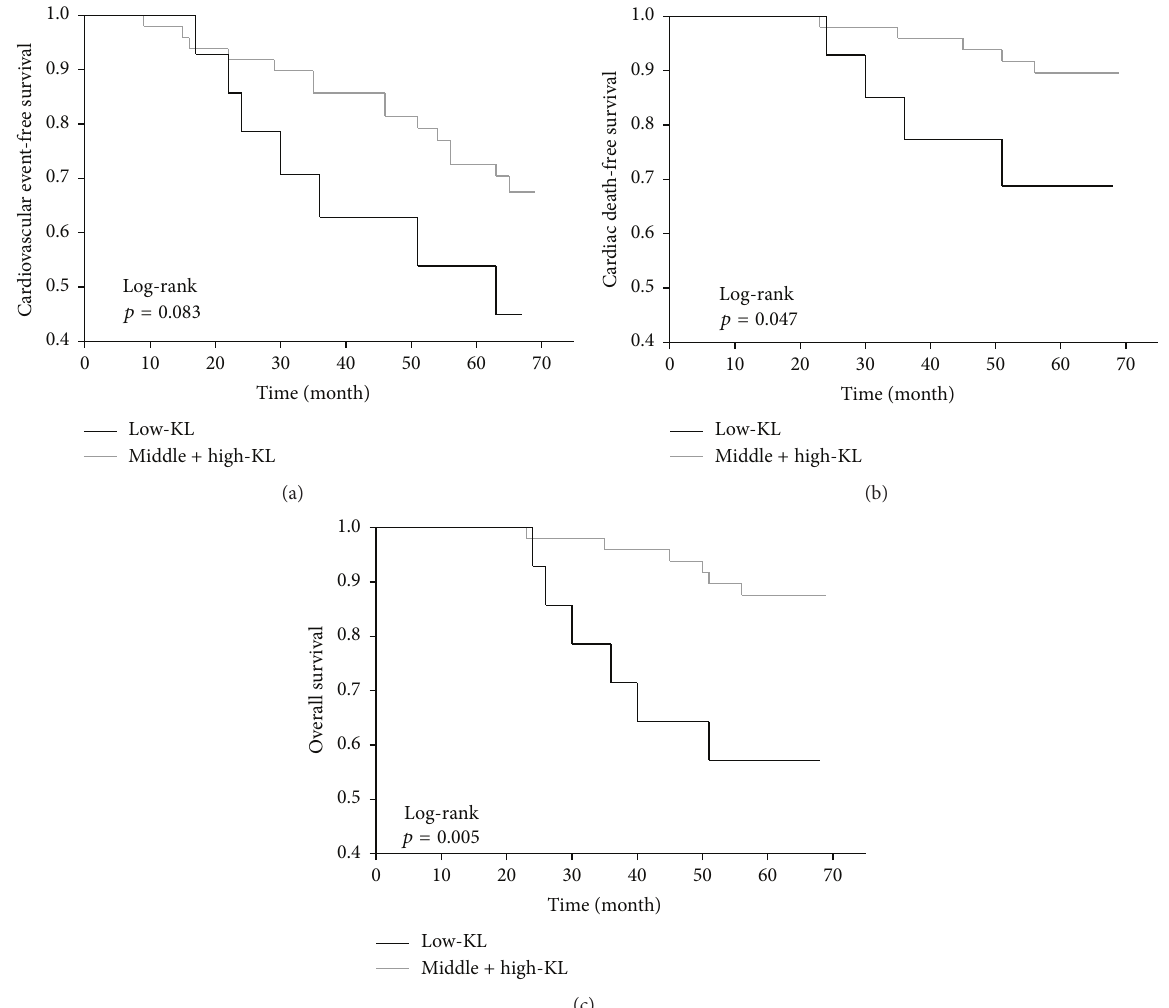
Figure 2: Cardiovascular event-free survival (a), cardiovascular mortality (b), and cumulative survival (c) by the 25th percentile of serum soluble Klotho. Note that the patients categorized into the low-KL ( < 309pg/mL) group had poorer cardiovascular ( 𝑝 = 0.047 ) and cumulative survival ( 𝑝 = 0.005 )